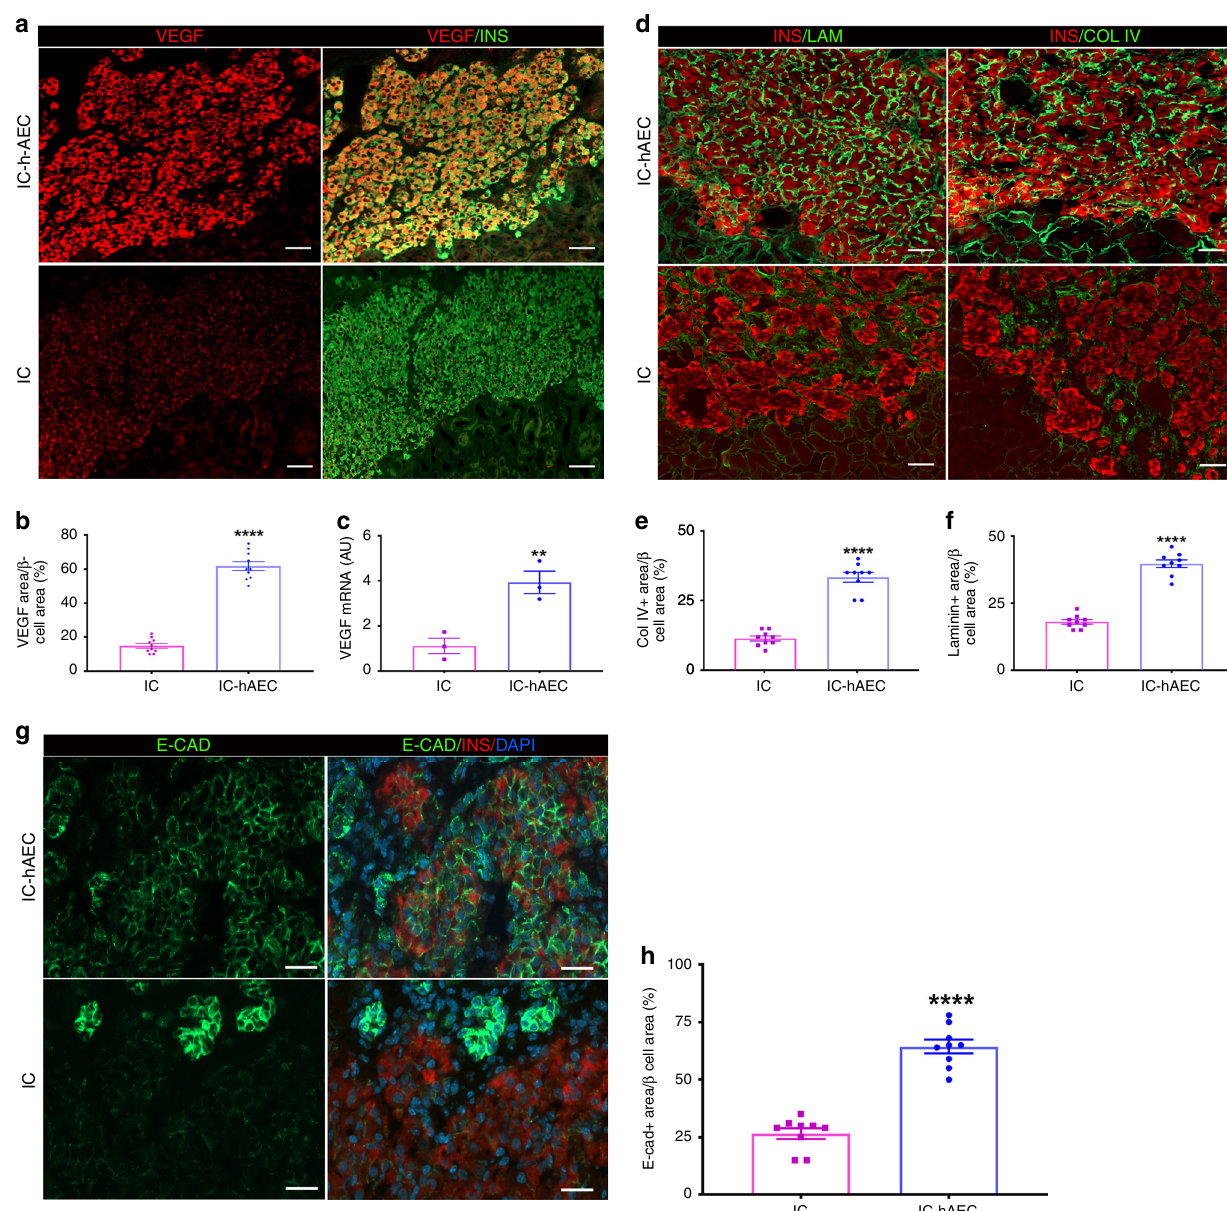
Fig. 7 The mechanisms of the enhanced vascularization and improved function of the IC-hAEC grafts. a The graft-bearing kidneys stained for VEGF-A and insulin at day 14 after transplantation. Scale bars = 100 μ m. b The mean VEGF-A expression per insulin-positive area, **** p < 0.0001 vs IC group, unpaired Student ’ s t test, n = 10. c VEGF-A mRNA expressed by IC and IC + hAEC spheroids as analyzed by qPCR, data presented as arbitrary units (AU) after normalization to housekeeping genes, with the IC group set to, ** p < 0.001 vs IC group, unpaired Student ’ s t test, n = 3. d Representative images of the grafts labeled for collagen IV, laminin and insulin. Scale bars = 100 μ m. e , f The Col IV-positive and the laminin-positive areas were calculated as a percentage of the graft area, **** p < 0.0001 vs IC group, unpaired Student ’ s t test, n = 10. g , h Expression of E-cadherin as analyzed by immunohistochemistry in the graft site was considerably upregulated in the IC-hAEC group. Scale bars = 100 μ m. **** p < 0.0001 vs IC group, unpaired Student ’ s t test, n = 10. All data shown are mean ± monocellular spheroids (IC- and hAEC spheroids) dispersed islet cells (ICs) and FITC- or Cy3-conjugated secondary antibodies. Finally, cells were rinsed with PBS hAECs (128,000 cells/cast and 500cells/spheroid) were seeded alone. Islet orga- and mounted with aqueous mounting solution containing DAPI (4 ′ ,6-diamidino- noids were formed by mixing ICs and hAECs at a ratio of 1:1 (128,000 cells/cast 2-phenylindole; ProTaqs MountFluor Anti-Fading, Quartett Biochemicals, Berlin, and 500 cells/organoid). The number of islet cells was chosen in order to obtain IC Germany) for nuclear counterstaining. spheroids of ~150 μ m diameter, i.e., the size of an “ islet equivalent ” (IEQ). After cell seeding, agarose casts were centrifuged at 500 g for 5min to trap the Generation of spheroids . Spheroids were generated on 3D agarose-patterned cells into the microwells and cultured for 5 days. Culture medium was changed microwells by distributing 500 μ l of warm, sterile 2.5% agarose (Promega, every other day. Cell aggregation and spheroid formation were observed daily Dübendorf, Switzerland) solution into 256-well micromolds, with a well diameter under the microscope. Spheroids were removed from the casts by upside down 400 μ m (3D Petri Dish; Microtissues Inc., Sigma-Aldrich). After solidi fi cation, centrifugation at 300g for 2min. The average diameters of spheroids were agarose casts were removed from the molds, transferred into 12-well culture plates, measured by analyzing light microscopy images using ImageJ software (NIH, washed three times with PBS and stored at 4°C until used. Before cell seeding, the Bethesda, MD). agarose casts were equilibrated in culture medium for at least 1h at 37°C. To form